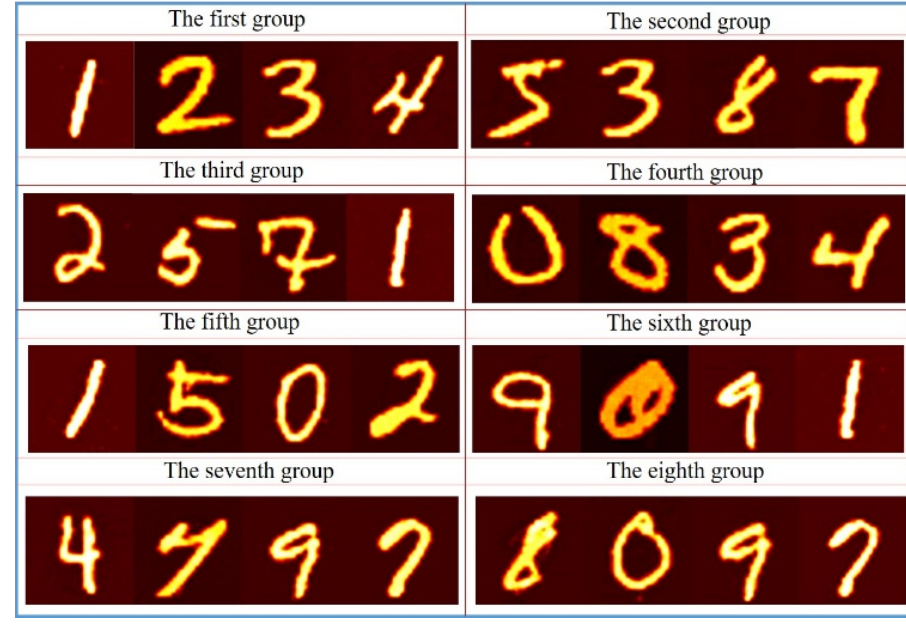
Figure 7. Decryption results for all groups.